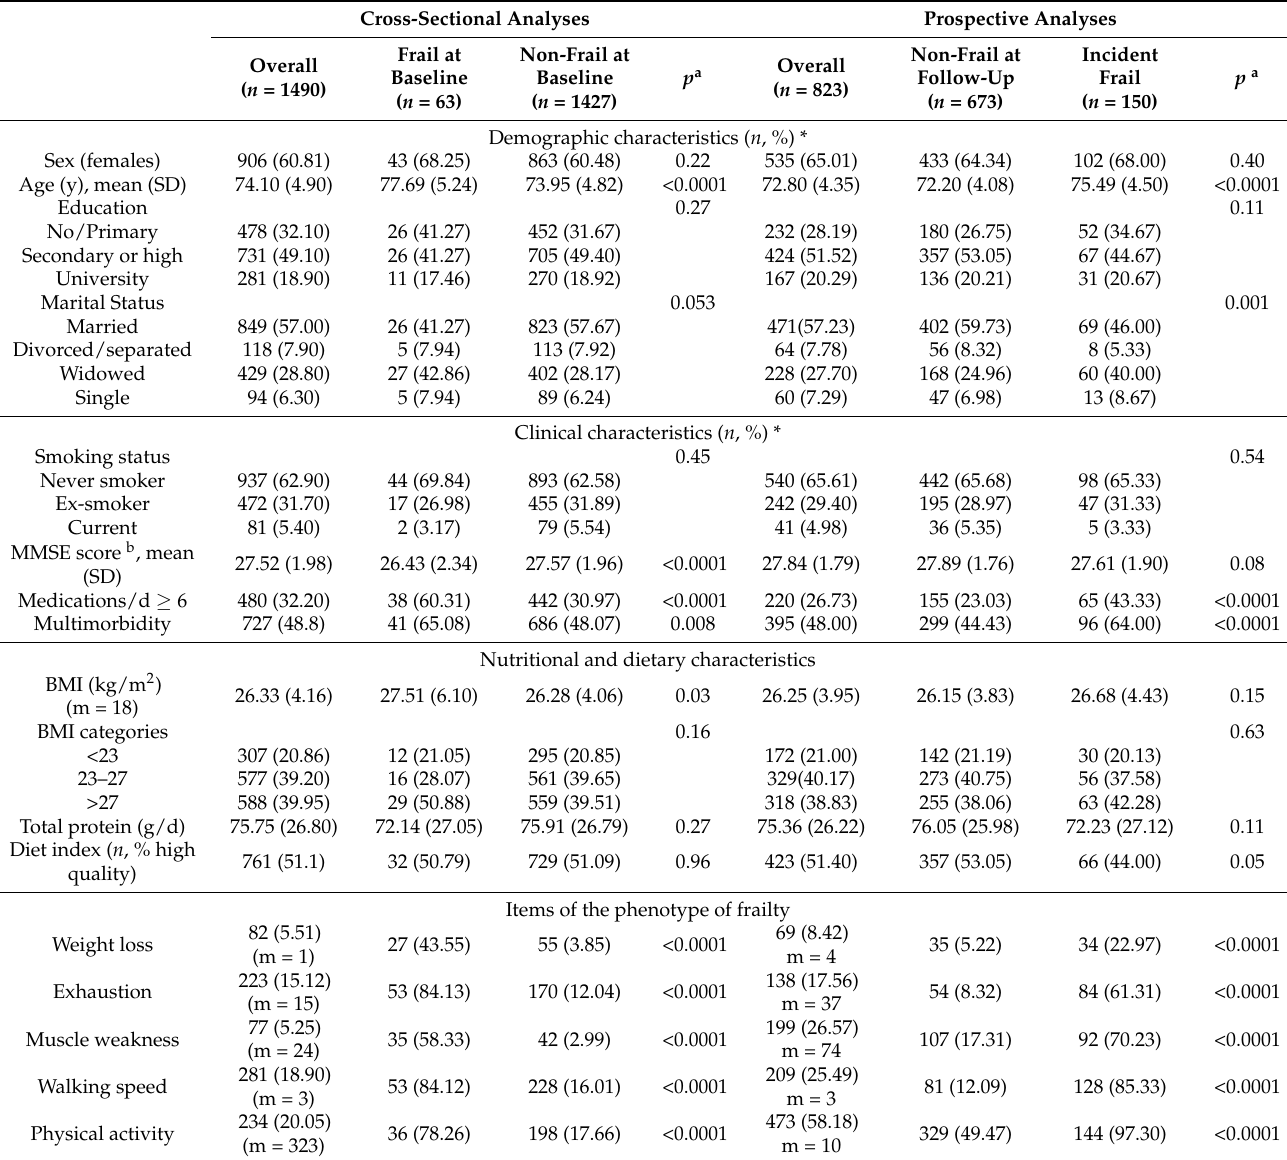
Table 1. Socio-demographic, clinical, dietary, and lifestyle characteristics according to the frailty prevalence (cross-sectional sample, n = 1490 in 2000) and incidence (prospective sample, n = 823 between 2000–2010) of older adults from the Three-City study, Bordeaux